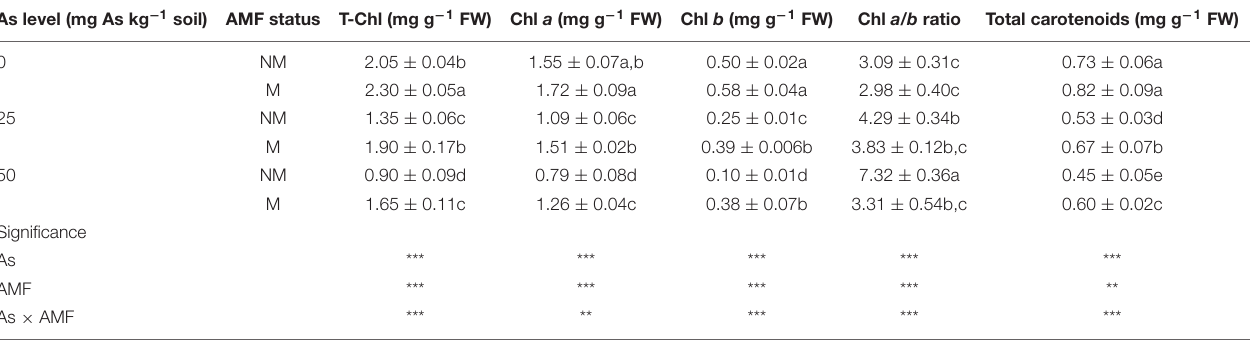
TABLE 2 | Concentrations of total T-Chl, Chl a , Chl b , total carotenoids, and Chl a/b ratio in leaves of Triticum aestivum in response to Rhizophagus intraradices inoculation (M, mycorrhizal; NM, non-mycorrhizal) and As addition to